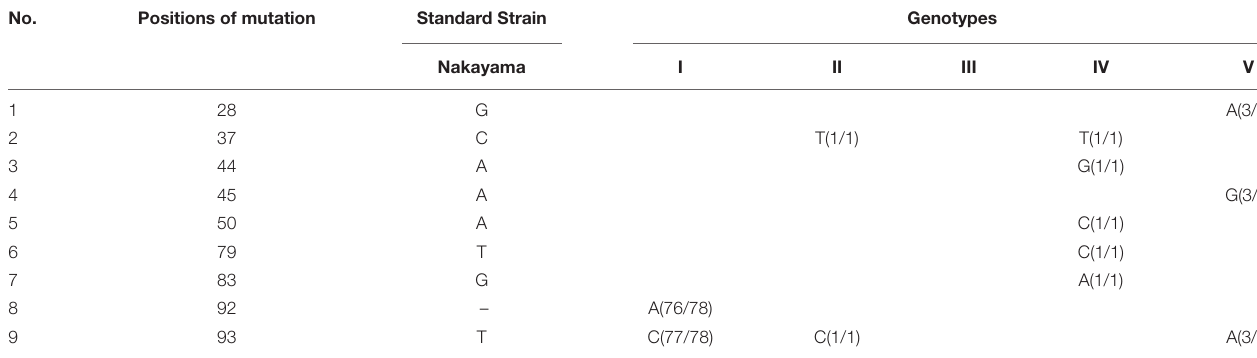
TABLE 2 | The nucleotide differences within the 5 (cid:48) UTRs between five JEV genotypes. No. Positions of